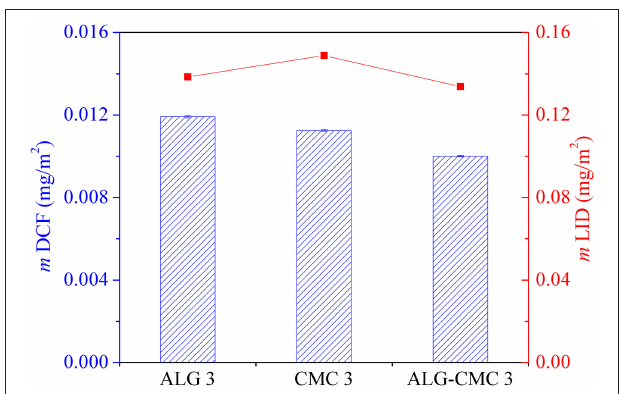
FIGURE 5 | Total amount of released drug mass from different spin-coated polysaccharide multi-layered thin films.